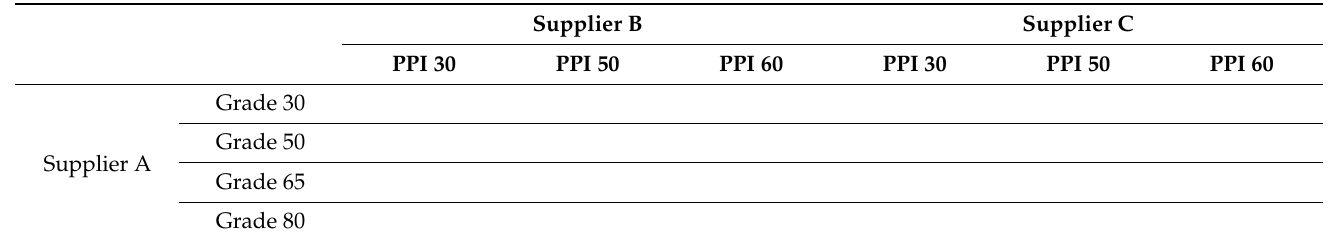
Table 6. The corresponding CFF of 30, 50, and 60 PPI from supplier B and supplier C with the Grades 30, 50, 65, and 80 from supplier